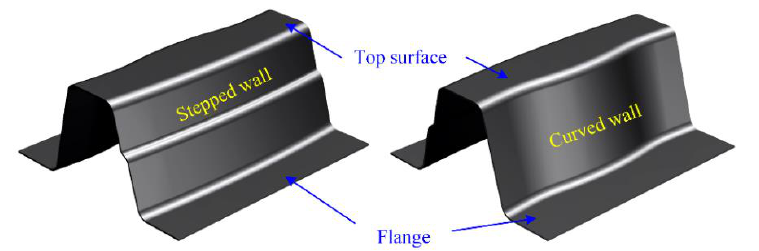
Figure 2. The shape characteristics of similar U-shaped sample (3D drawing).